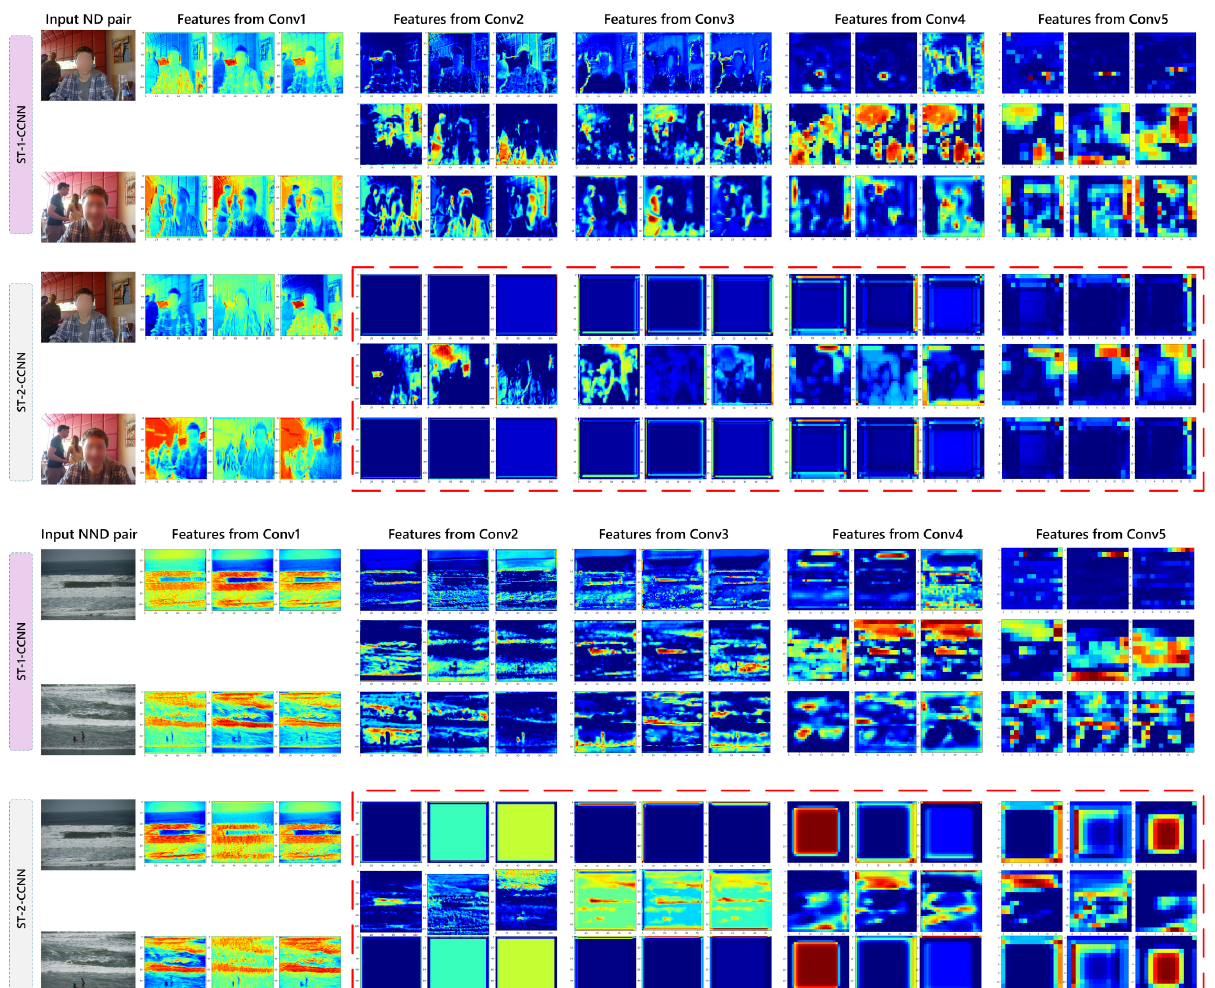
Figure 10. Visualization of the first three slices feature maps on each convolutional set of networks with ST modules on single/dual image stream. The dual here represents the CCNN equipped with parallel ST modules not sharing